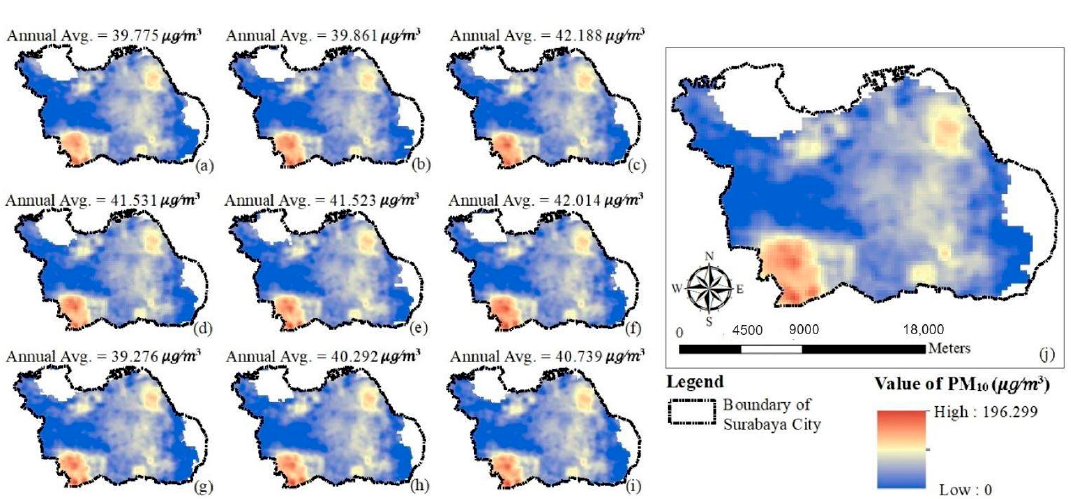
Figure 4. Prediction maps of PM 10 concentration variations using GWR model: ( a ) 2010 ( b ) 2011 ( c ) 2012 ( d ) 2013 ( e ) 2014 ( f ) 2015 ( g ) 2016 ( h ) 2017 ( i ) 2018 ( j ) average from 2010 to 2018.